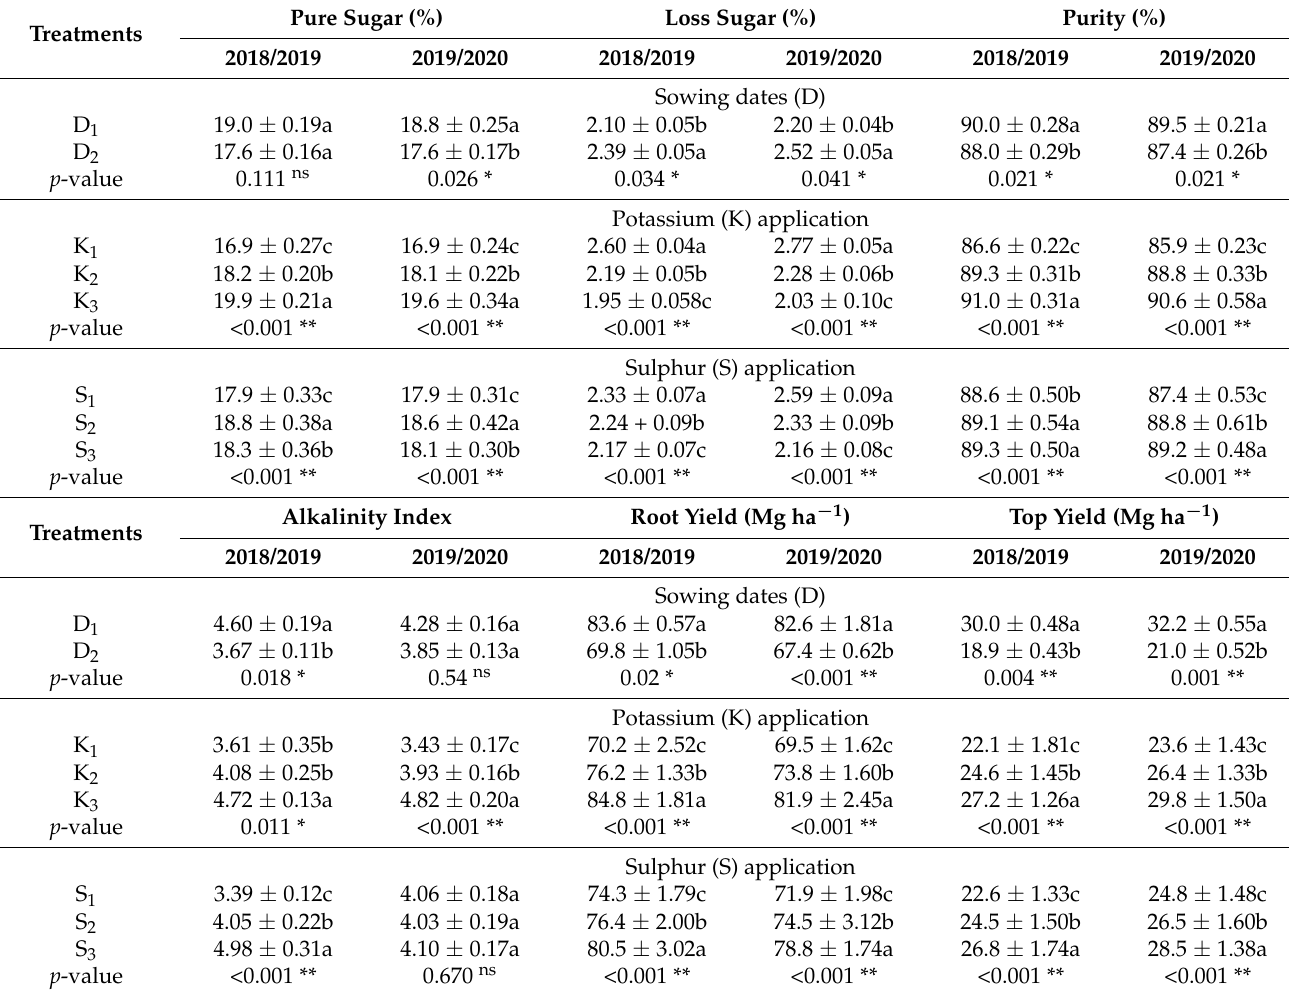
Table 5. Effect of sowing dates and applications of potassium and sulfur level and their interactions on pure sugar (%), loss sugar (%), purity (%), alkalinity index, and yields of roots and tops (Mg ha − 1 ) of sugar beet during two growing